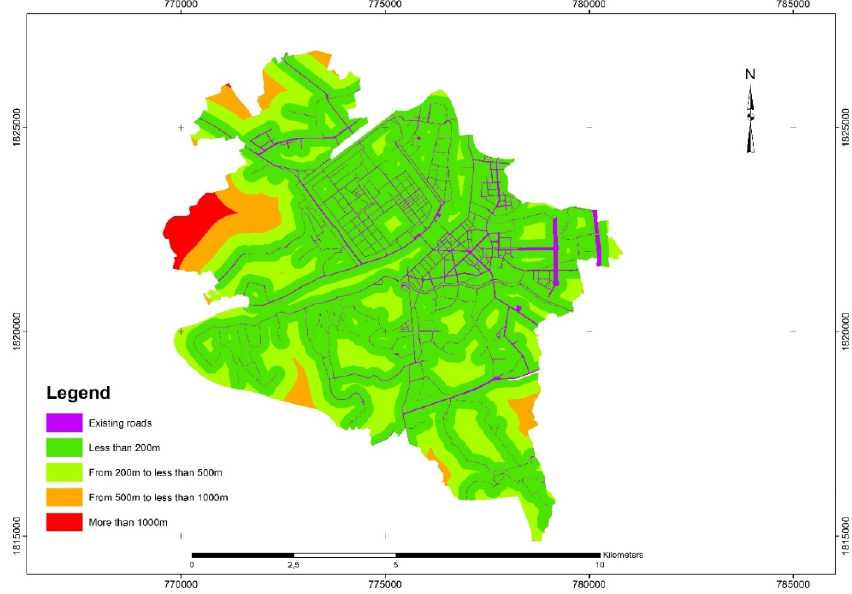
Figure 6. Map of the distance from main roads ( sources: authors; Land Use Map in 2020 of Hue City ).